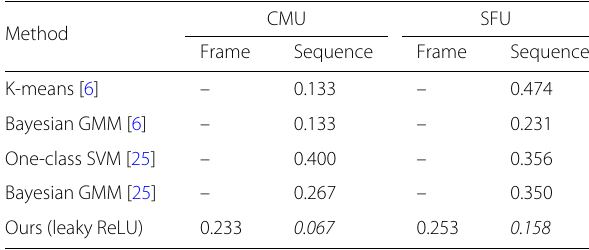
Table 6 EERs obtained from experiments on two additional datasets